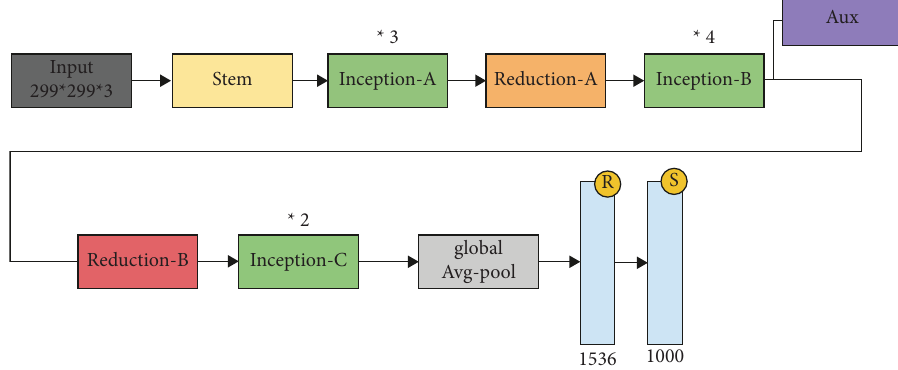
Figure 4: InceptionV3 architecture.